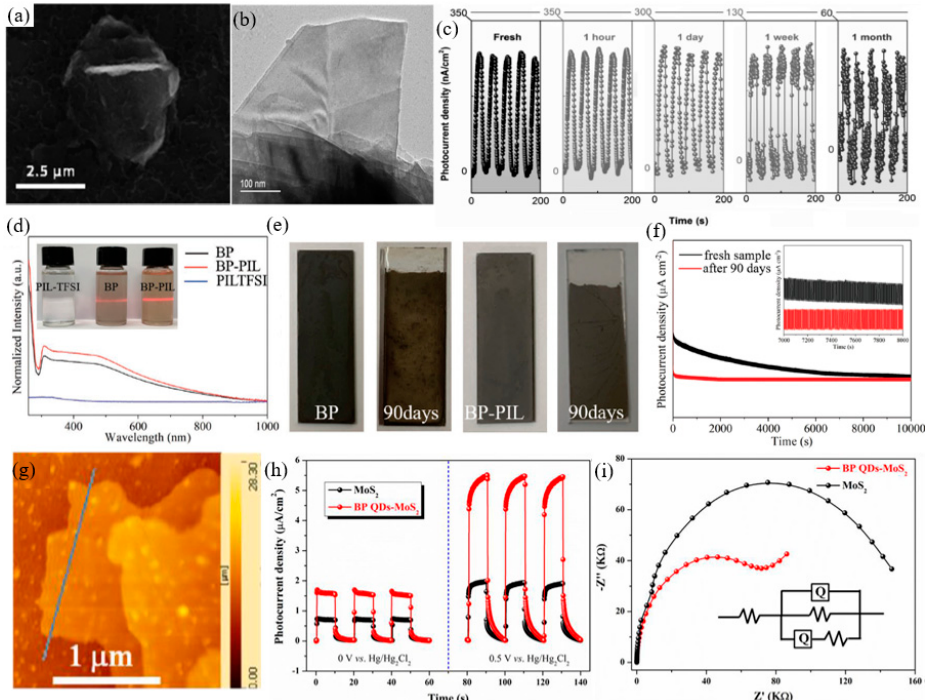
Figure 26. ( a ) Scanning electron microscope photograph of exfoliated BP. ( b ) Transmission electron microscope photograph of exfoliated BP. ( c ) Current density curve with time [317]. Copyright 2017 Wiley-VCH Verlag [318]. Copyright 2019 Wiley-VCH Verlag. ( d ) The optical and composition characteristic analysis. ( e ) The imaging of BP QDs and BP-PIL, which undergo three months testing. ( f ) The photocurrent intensity curves of the newly prepared material and the stability tested material, and the illustration shows the received signal during 7000–8000 s [318]. Copyright 2019 Wiley-VCH